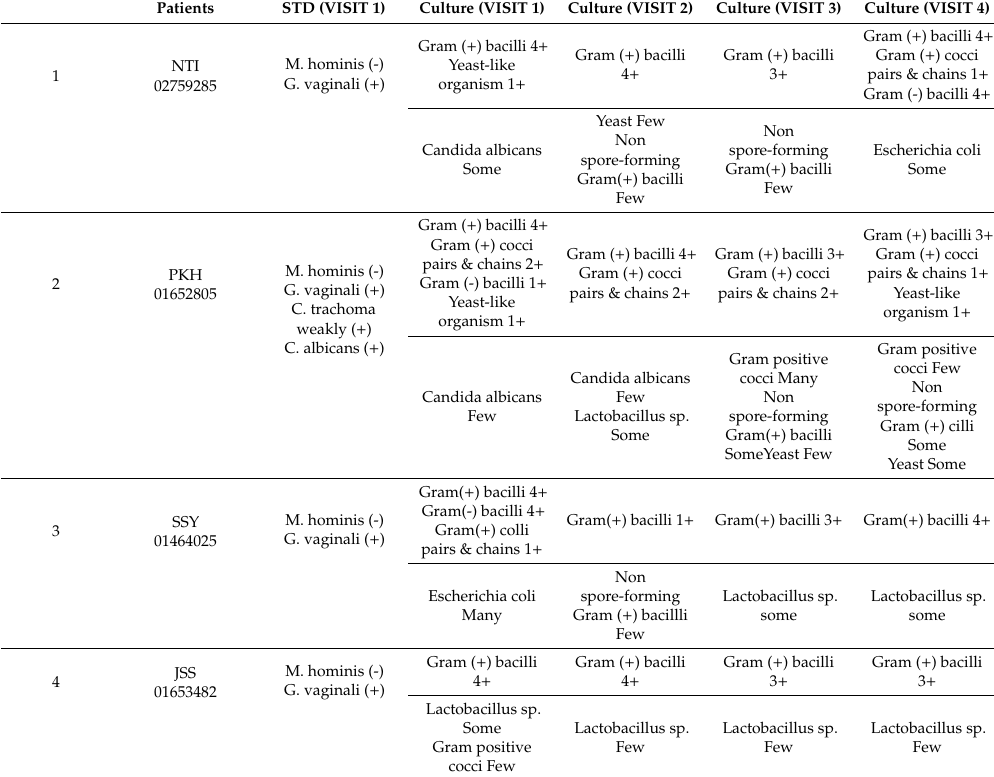
Table 2. Information and test results of experimental